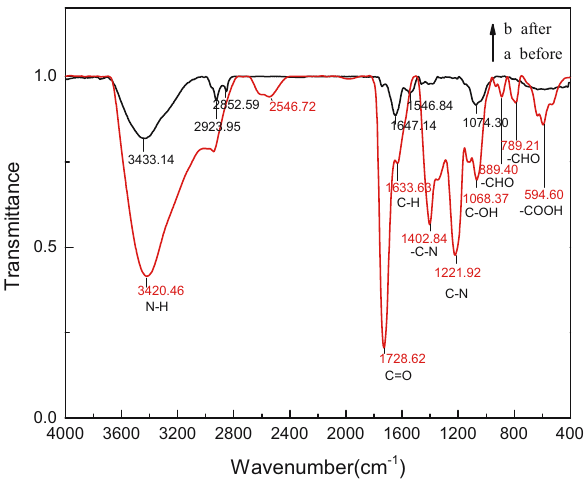
Figure 6: FTIR spectra of lemon juice before ( a ) and after ( b ) SeNPs was